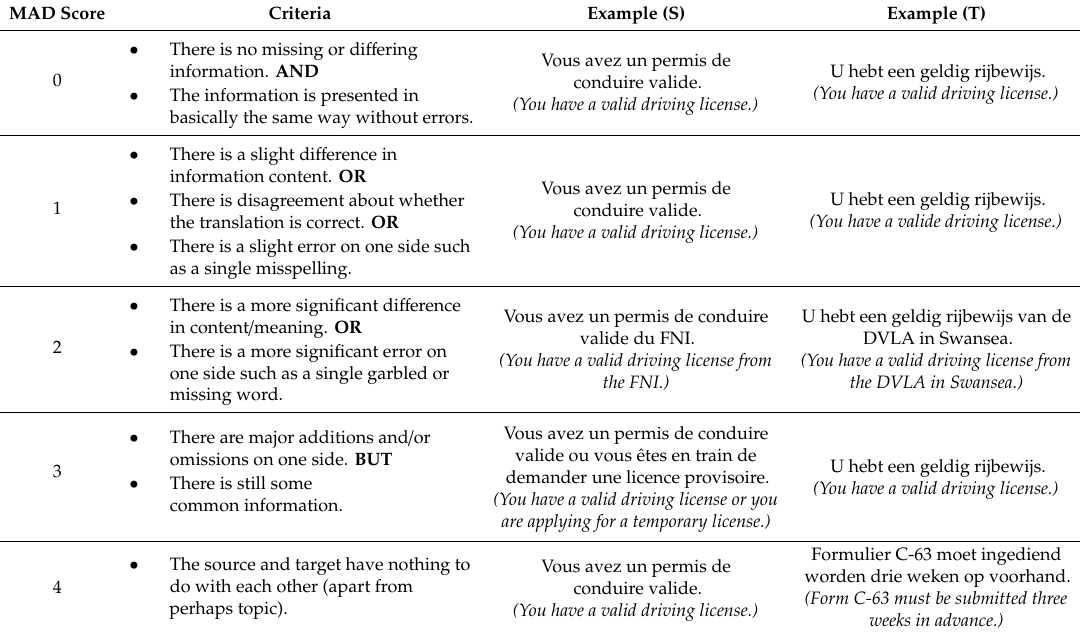
Table 1. Description of criteria used for labeling of the sentence pairs (S,T) from the dataset. In brackets, we show the translation into English of the French andDutch sentences respectively for the non-French and / or Dutch speaker.